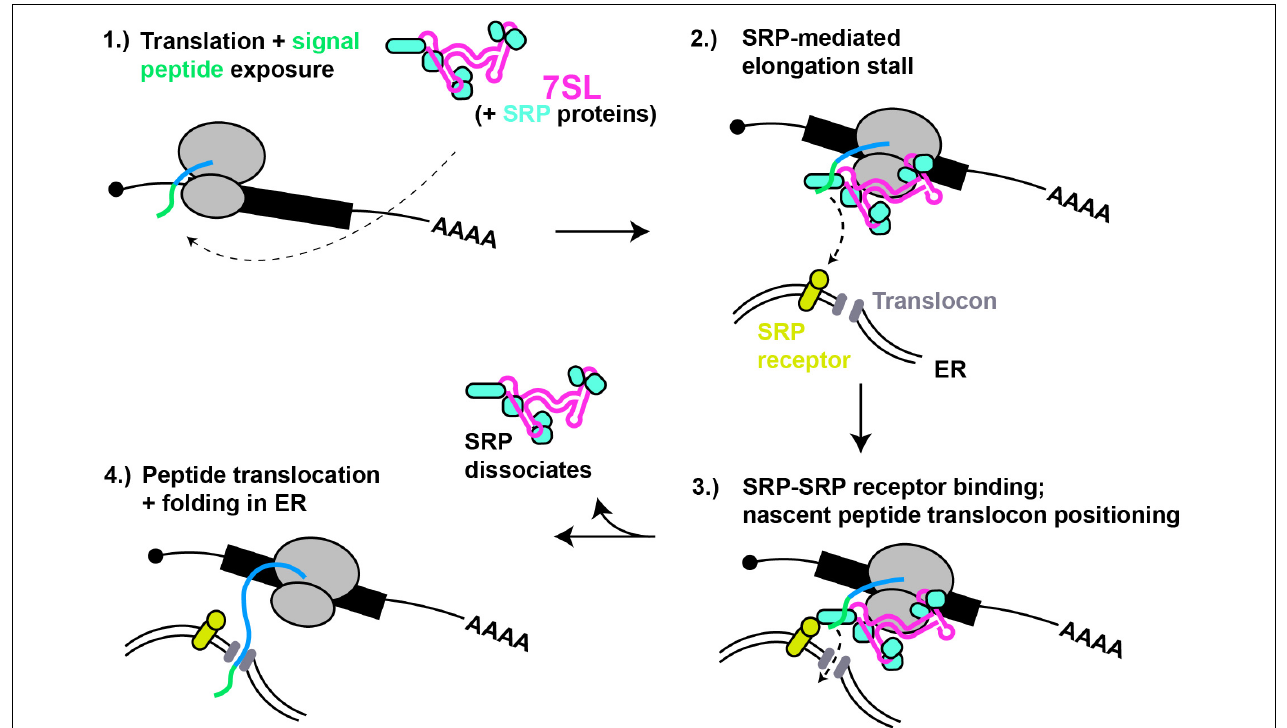
FIGURE 2 | 7SL – a paradigm of cytoplasmic RNA scaffolding. (1) Translation of proteins with N-terminal signal peptides (green) are bound by SRP complex, scaffolded by 7SL. (2) Signal peptide binding induces SRP conformational change and tighter binding, thus block ribosomal A-site and stalling translation elongation. (3) SRP interaction with SRP receptor positions nascent peptide for entry into ER translocon. (4) Dissociation of SRP relieves elongation stall, and nascent peptide extends into and folds within ER